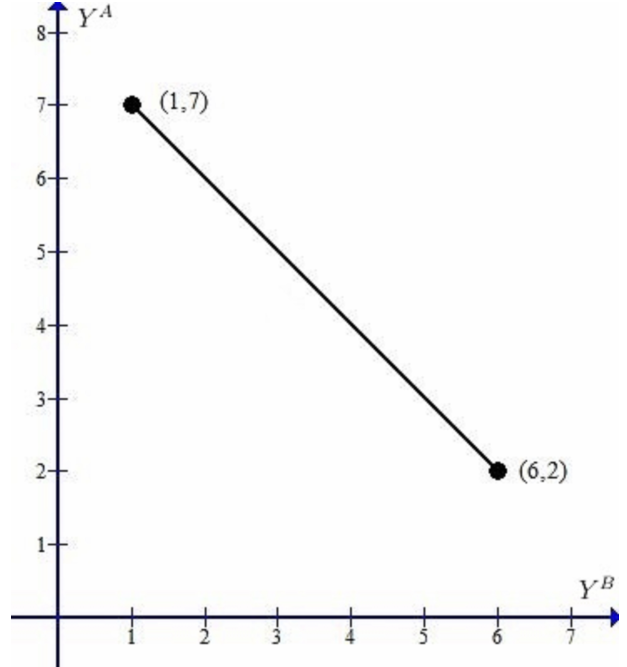
Figure 3. Trade-off